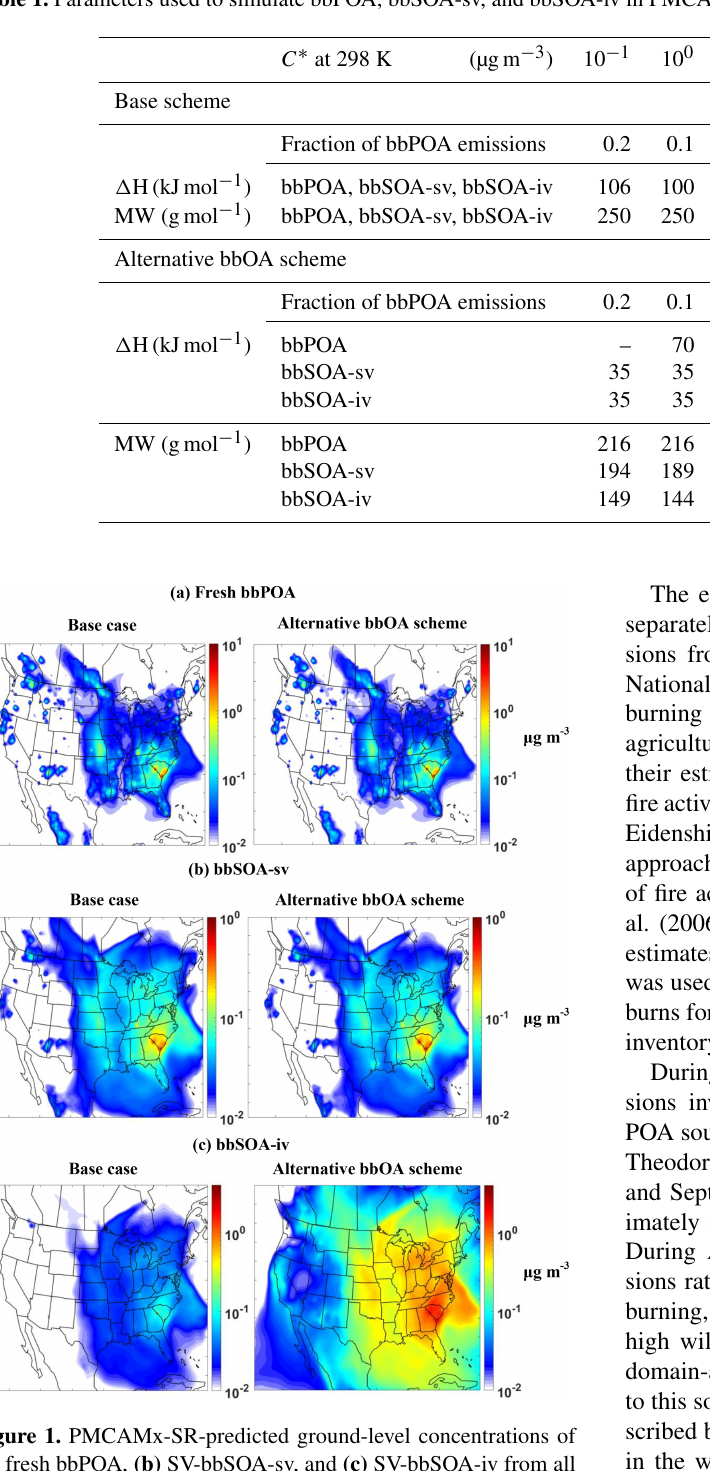
Table 1. Parameters used to simulate bbPOA, bbSOA-sv, and bbSOA-iv in PMCAMx-SR.